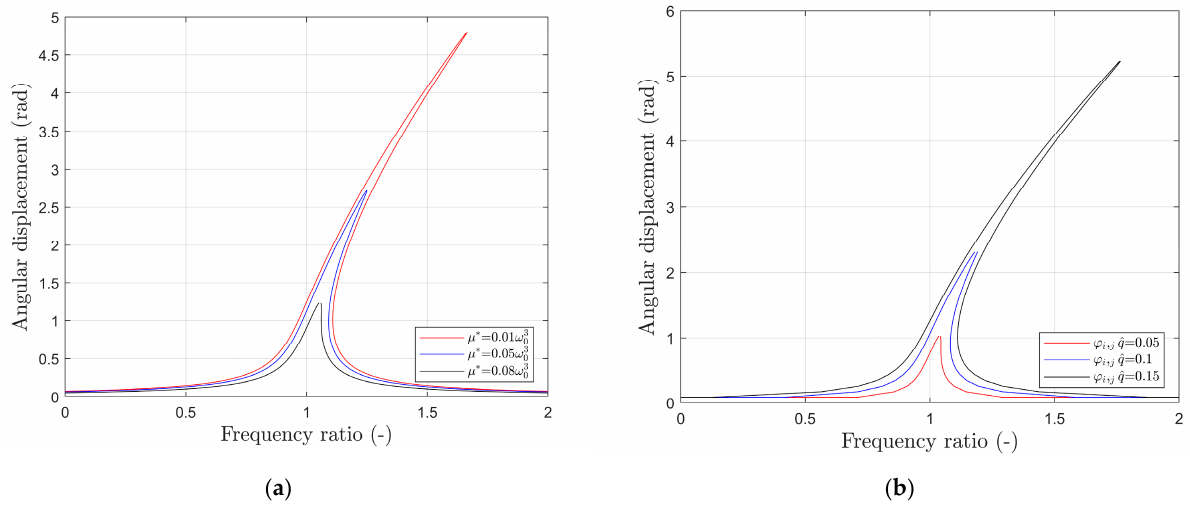
Figure 6. Comparison of frequency-response curves when varying the ( a ) friction damping coefficient (cid:2020) ∗ ( (cid:2009) ∗ = 0.1(cid:2033) (cid:2868)(cid:2870) ,(cid:1856) ∗ = 0.05(cid:2033) (cid:2868) ,(cid:2030) (cid:3036),(cid:3037) (cid:1869)(cid:3548) = 0.15 ) and ( b ) excitation amplitude (cid:2030) (cid:3036),(cid:3037) (cid:1869)(cid:3548) ( (cid:2009) ∗ = 0.1(cid:2033) (cid:2868)(cid:2870) ,(cid:1856) ∗ = 0.05(cid:2033) (cid:2868) ,(cid:2020) ∗ = 0 ).